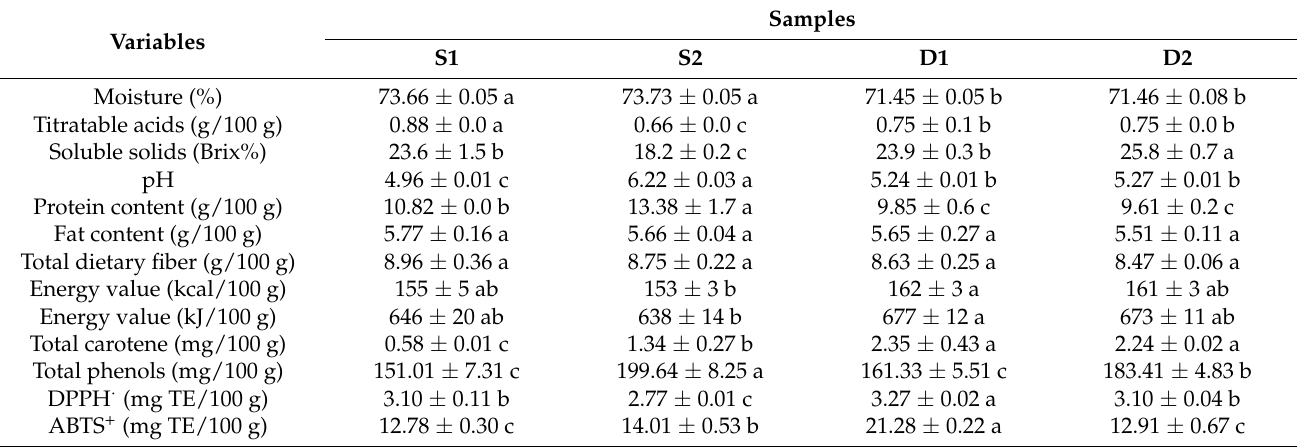
Table 6. Physical and chemical characteristics of industrially produced plant-based pur é es intended for OD